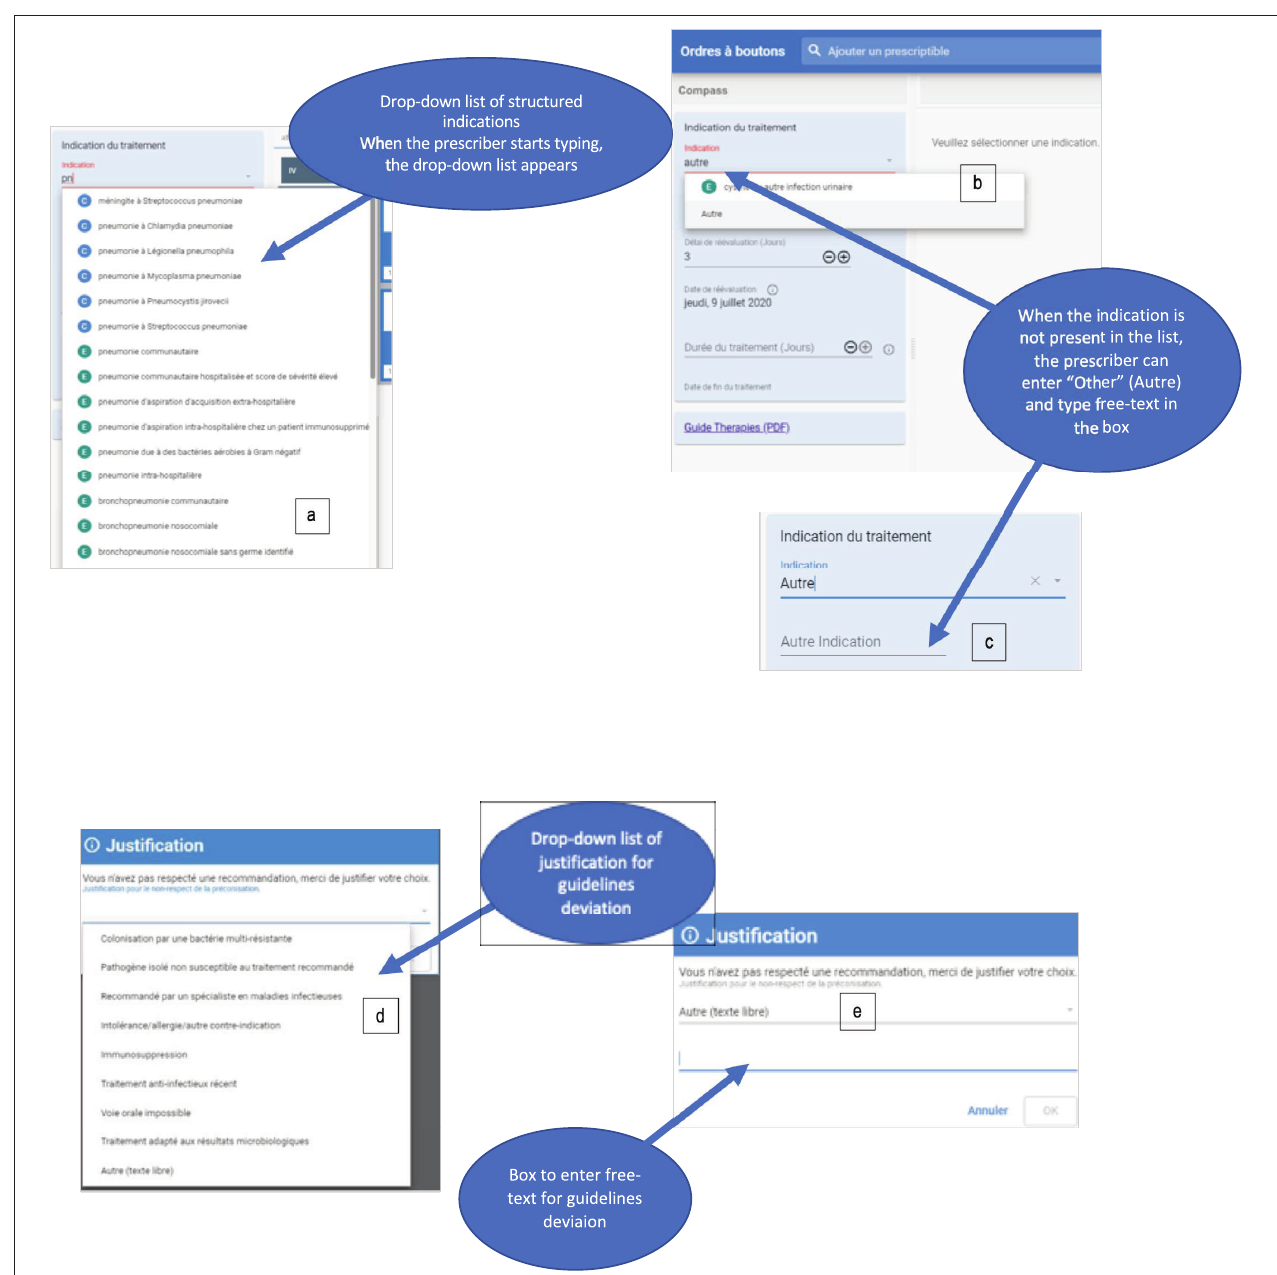
FIGURE 2 | Screenshots of the CDSS. (A) Dropdown list of indications, (B) selection of free-text indication by selecting “Autre” (“Other”) in the dropdown list and (C) entering free-text. (D) List of justification provided for guideline rejection, (E) by selecting “Autre” (Other), the specific box for free-text appears.